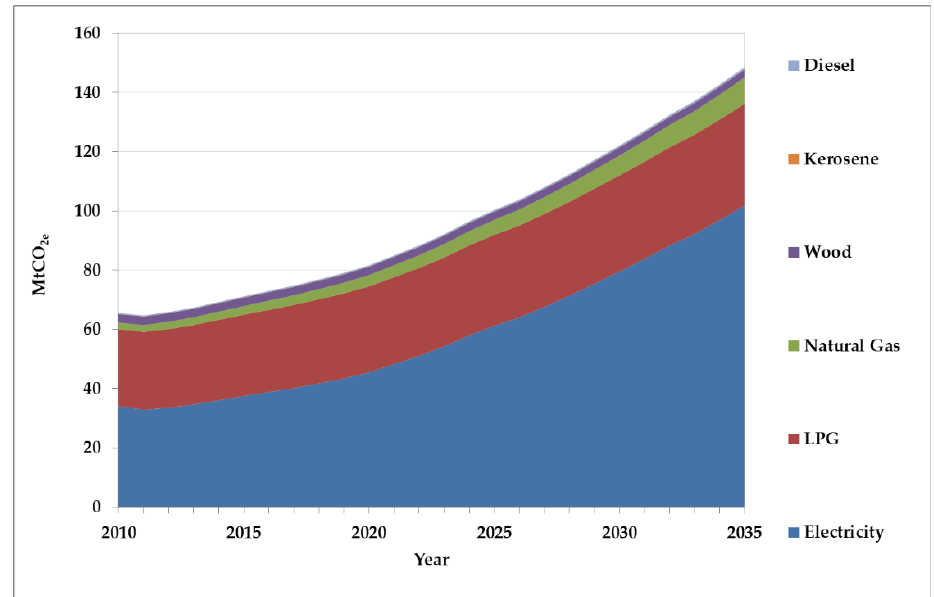
Figure 3. GHG emissions by source in the trend scenario for RCPS sectors, 2010–2035. Source: Own elaboration.